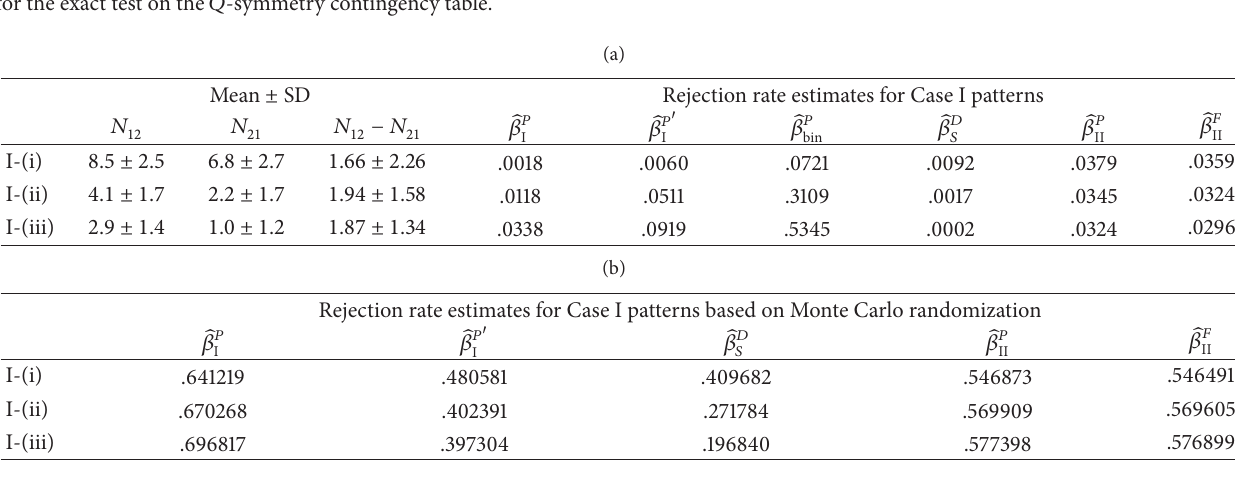
= 10000 , 𝑛 = 𝑛 = 40 at 𝛼 = .05 (a) and rejection rate estimates based on 1 2 mc ̂𝛽 𝑃 ̂𝛽 𝑃 󸀠 and stand for the empirical rejection rate estimates for Pielou’s first type of symmetry test using 𝜒 2 I I ̂𝛽 𝑃 stands for the exact binomial version of Pielou’s first type of bin ̂𝛽 𝐷 ̂𝛽 𝑃 is for Pielou’s second type of symmetry test; 𝑆 stands for Dixon’s symmetry test; II